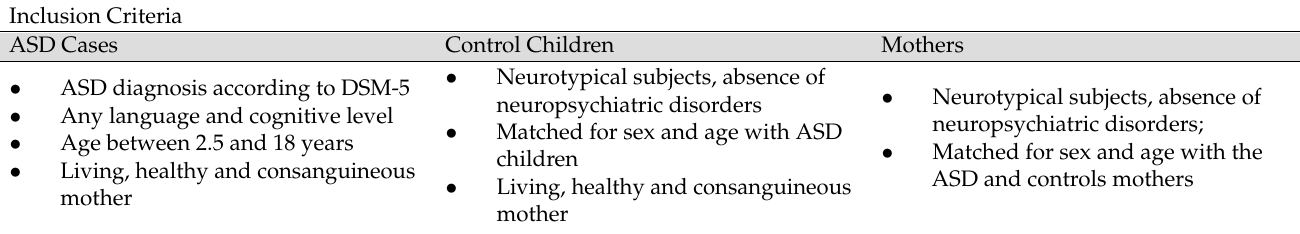
Table 1. Inclusion and exclusion criteria of the study